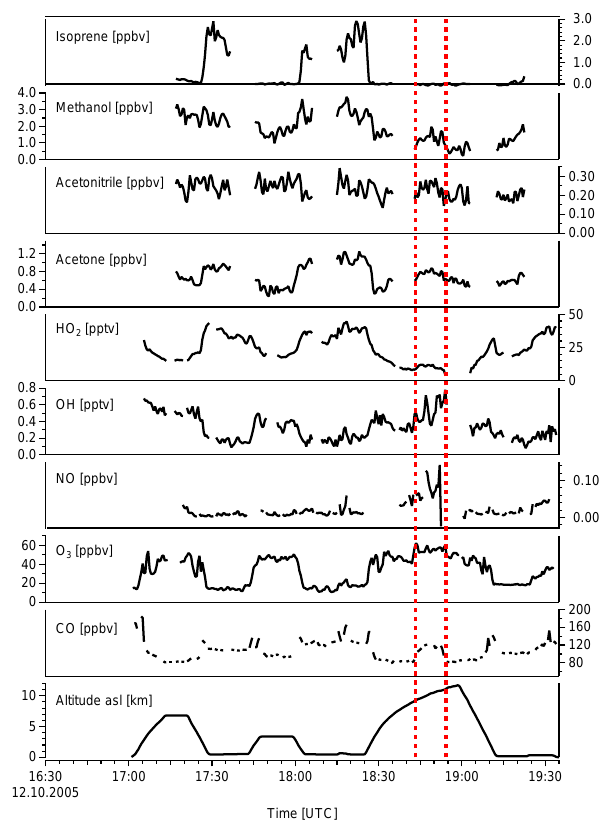
Figure 2. Time series of different species during flight GAB 08. The red dotted lines mark the time interval, where samples were taken in the outflow region of the cumulonimbus cell. The interval spans about 10 minutes.